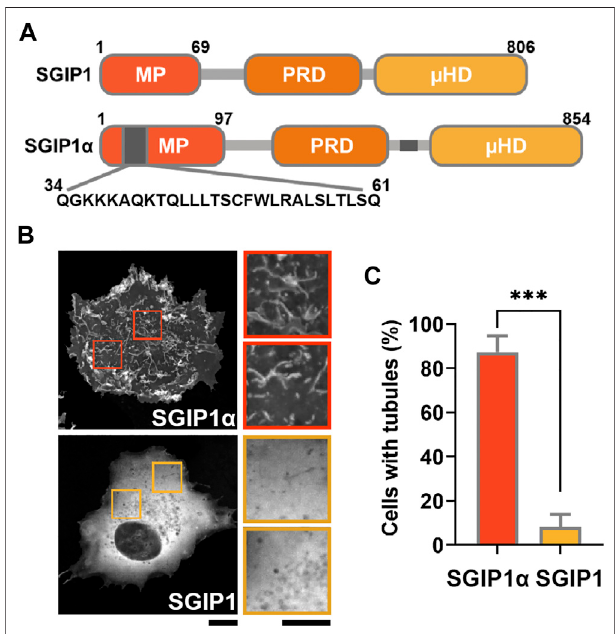
FIGURE 1 | SGIP1 α , but not SGIP1 deforms membrane into narrow tubules. (A) Schematicdiagramofthedomain structureofSGIP1andSGIP1 α constructs.GrayregionsindicatetheadditionalregionsintheMPdomain(a.a. 34 – 61) and the C terminal domain (a.a. 550 – 569). (B) Representative imagesofEGFP-taggedSGIP1andSGIP1 α expressedinCOS7cells,imaged 48 h after transfection. Scale bar: 10 and 2 μ m, respectively. (C) Quanti fi cation of the percentage of cells with tubules in (B) . EGFP-tagged SGIP1 α but not EGFP-SGIP1 expressed in COS7 cells deformed membrane into tubules. Cells were counted as tubule-positive when there were more than 5 visually-con fi rmed tubules, each ≥ 1.5 μ m in length. Error bars indicate mean ± s.e.m. n (cid:1) 3(50cells per constructfor each independent experiment). *** p < 0.001, Student ’ s t -test.